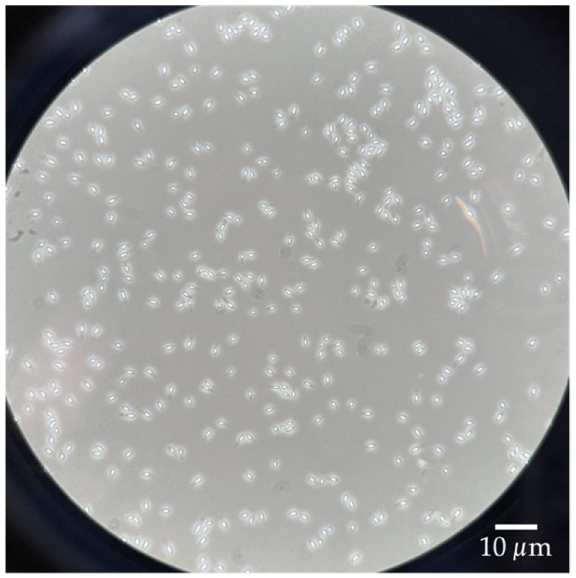
Figure 1. Purified spores of G. stearothermophilus (ATCC 7953) under the phase-contrast microscope